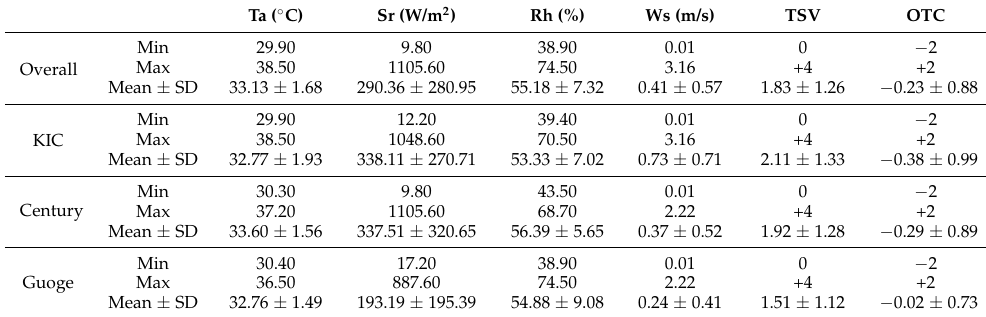
Table 2. Microclimate condition and thermal strain during experiment.